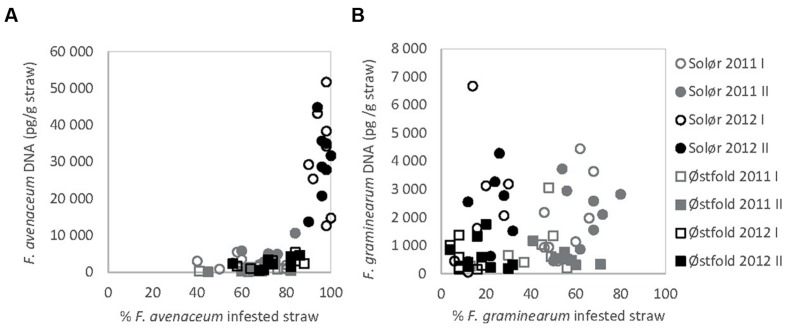
Association between the DNA content of F. avenaceum (A) and F. graminearum (B) per gram straw (pg DNA/g straw), analyzed by qPCR, and the percentage of Fusarium-infested straw within the same field plot, determined by morphological analyzes.